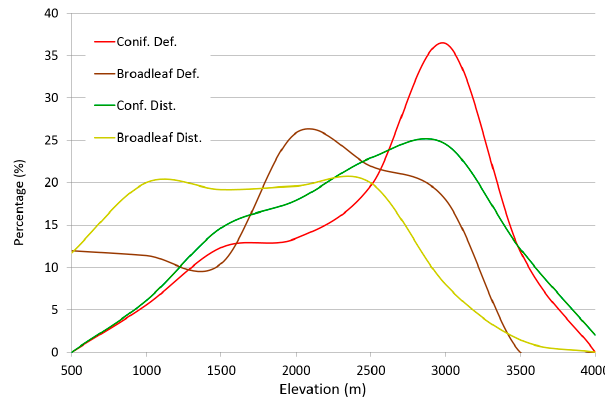
Figure 5. Forest cover and deforestation distribution as a function of elevation.